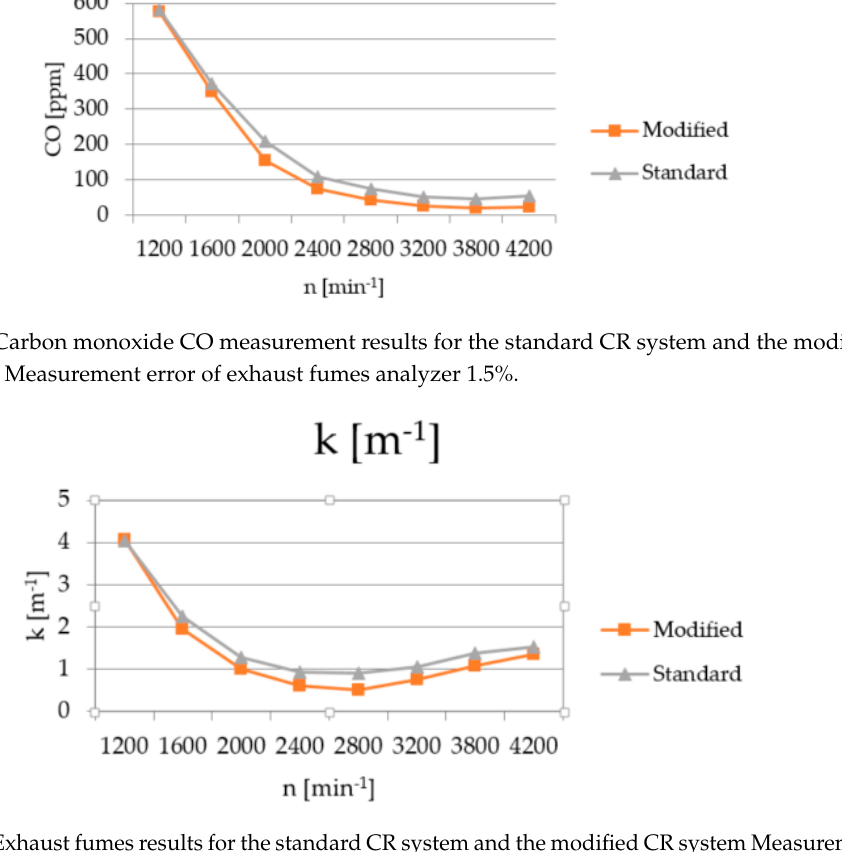
Figure 15. Exhaust fumes results for the standard CR system and the modified CR system Measurement error of the opacimeter: 2%.